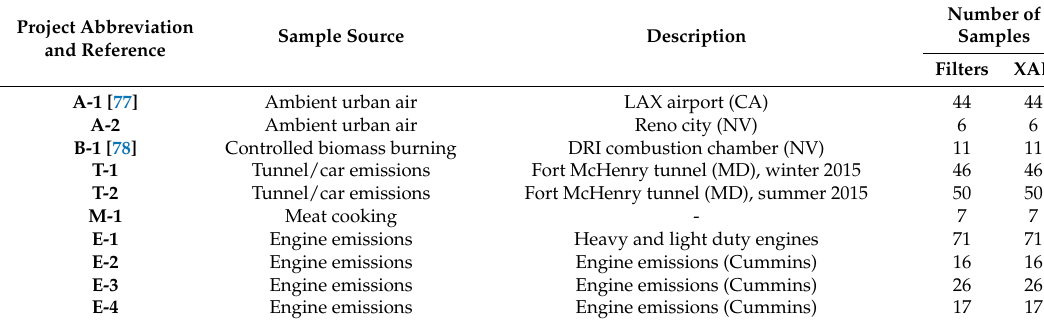
Table 1. List of projects and number of collected filter and XAD samples that were analyzed for PAHs in particle and gas phases,